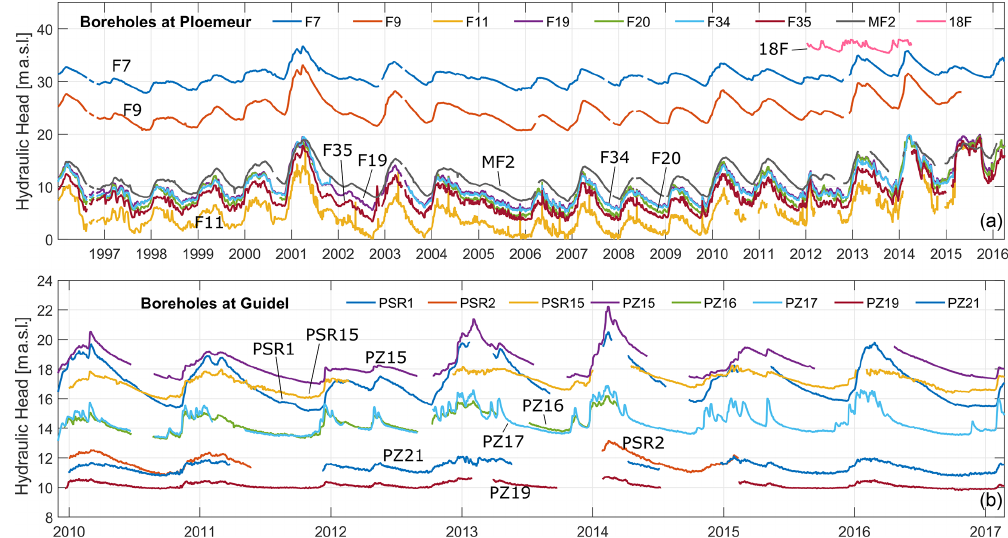
Figure 3. Observed GW-level variations in boreholes at the Ploemeur pumping site (a) and the Guidel natural site (b) . Note the difference in scales between the two sites. ma.s.l. refers to meters above sea level.